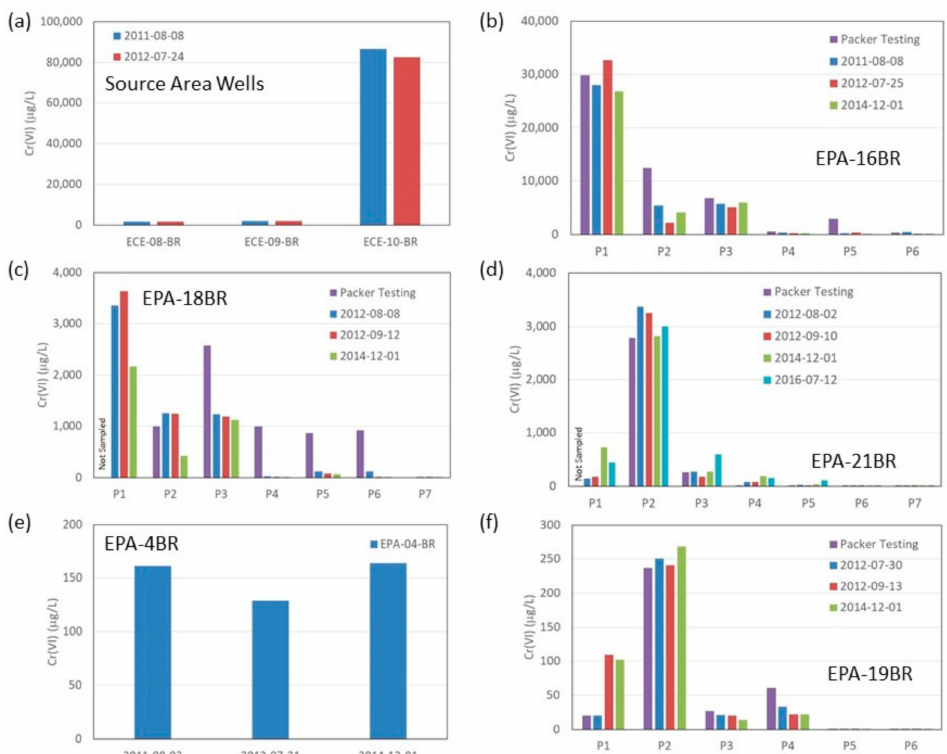
Figure 4. Temporal Cr ( VI ) groundwater sampling results for selected conventional wells and multilevel systems along the plume flow path organized by distance from the site (see Figure 2a for locations): ( a ) three source area bedrock wells, ( b ) EPA-16BR MLS, ( c ) EPA-18BR MLS, ( d ) EPA-21BR MLS, ( e ) EPA-4BR conventional well, and ( f ) EPA-19BR MLS. Samples were collected during drilling in 2010–2011 (packer testing) and from major sampling events between 2012–2014 and EPA-21BR sampling event in 2016.